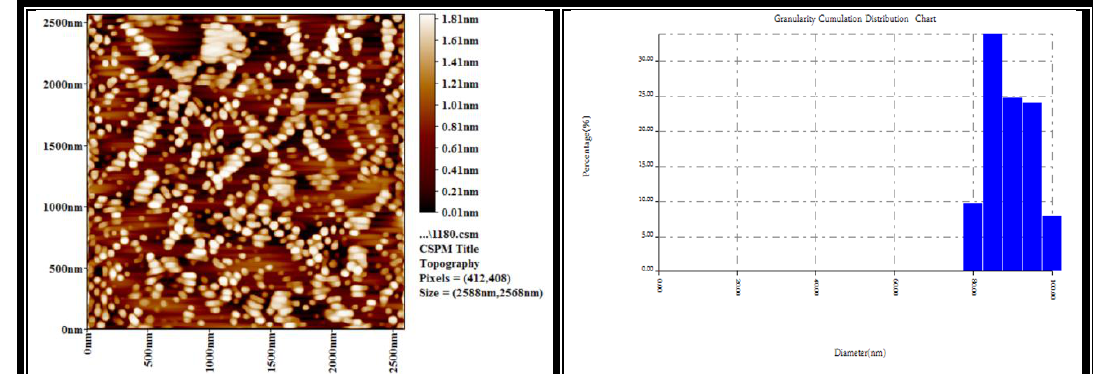
Fig.5: Surface roughness and histogram of Cr-doped TiO